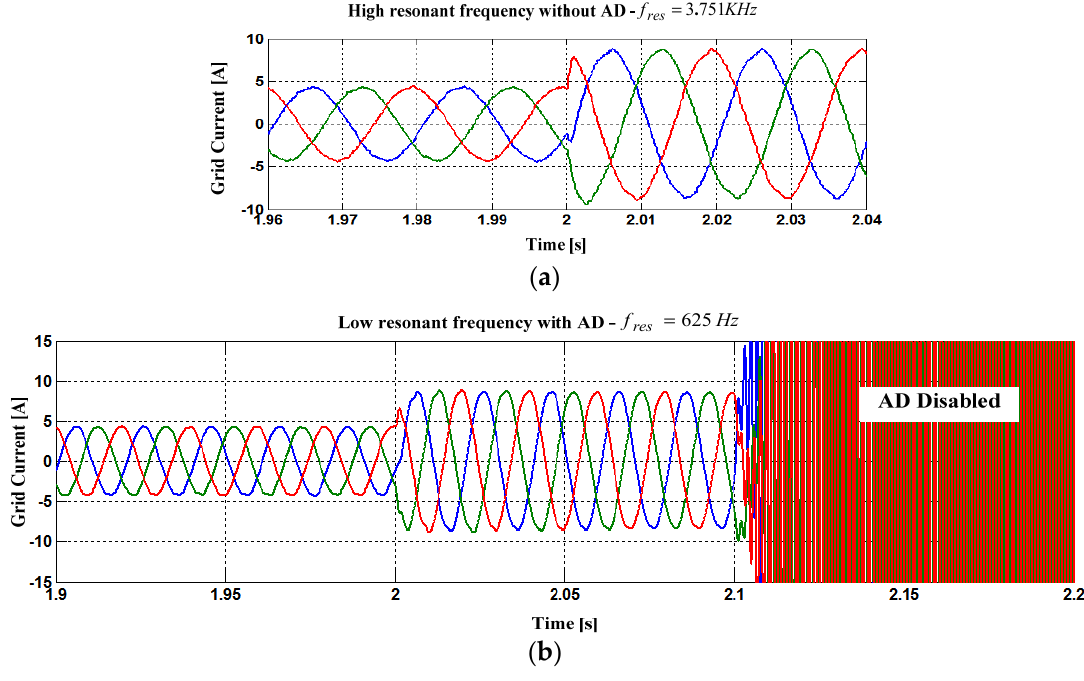
Figure 15. Simulation results of digitally-controlled LCL-filtered grid-connected inverter system: ( a ) high resonant frequency without AD ( K P = 0.116, K i = 60.736, C f = 1 μ F); and ( b ) low resonant frequency with enabling and disabling proportional capacitor feedback AD ( K P = 0.0261, K i = 3.075, K D = 0.039, C f = 36 µ F).